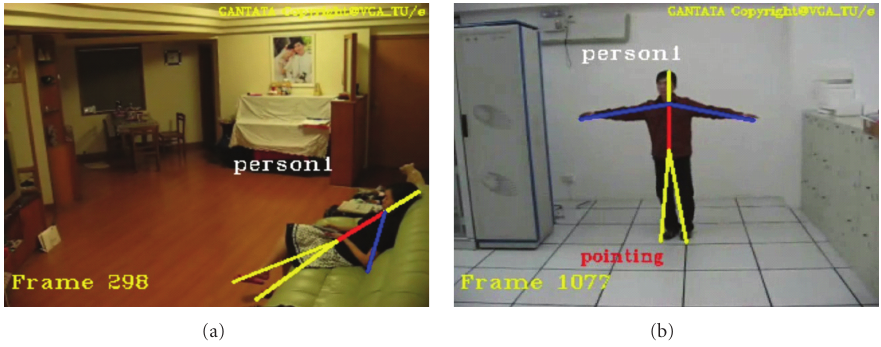
Figure 5: Example images of the skeleton-fitting result of human activity in two indoors events.